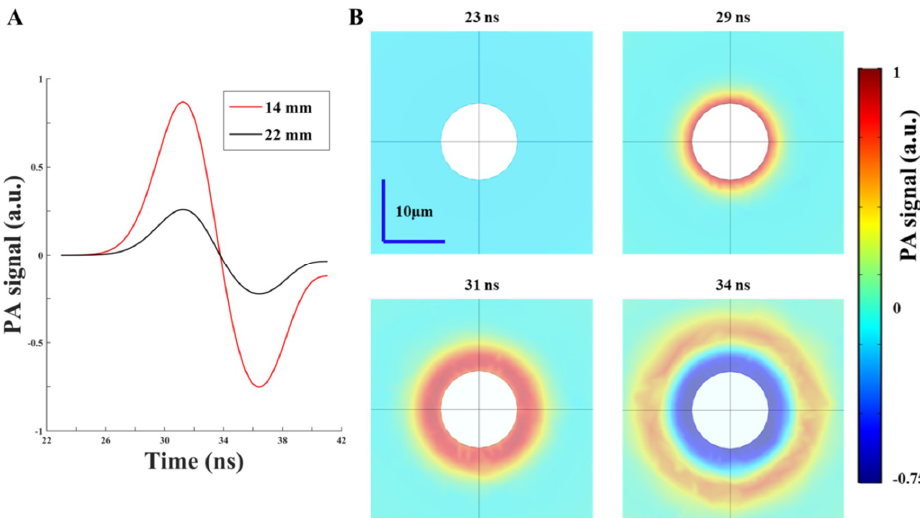
Figure 4. Simulated photoacoustic (PA) response using COMSOL. ( A ) The simulated PA signals with different intervals between the two arms of the fiber bundle. The intensity of the PA signal with a 14-mm interval was 3.35-fold larger than the PA signal with a 22-mm interval. ( B ) The X-Z plane time sequence snapshots of the PA wave field at 4 representative time points in 1% Lipofundin. When the target received a Gaussian light pulse (peak time at 30 ns), the PA wave started to generate from the surface of the target and propagated outward in the scattering